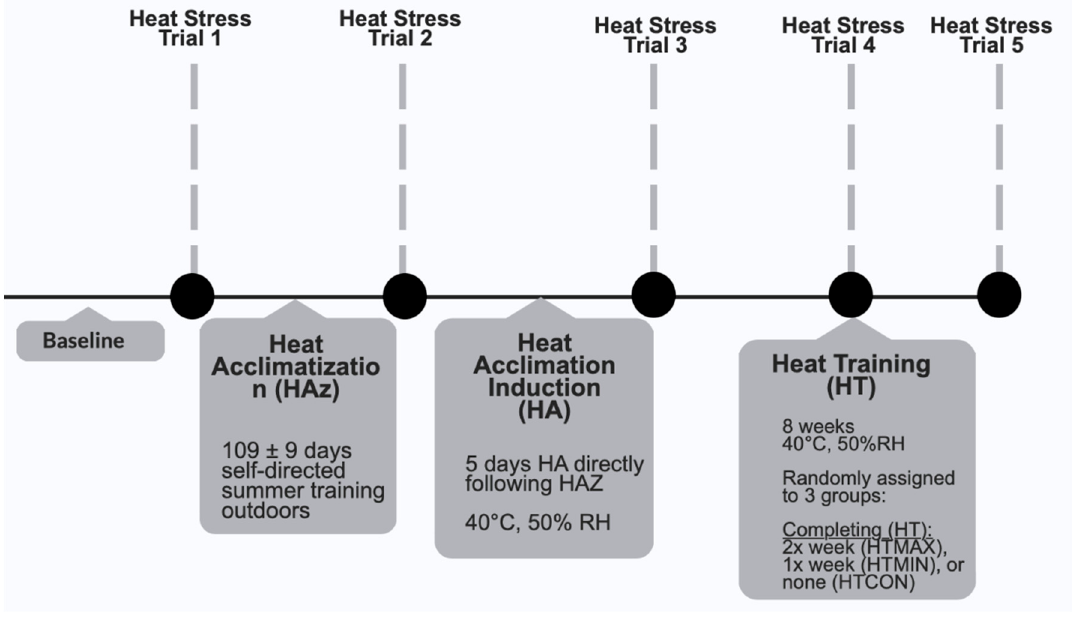
Figure 1. Experimental study design.